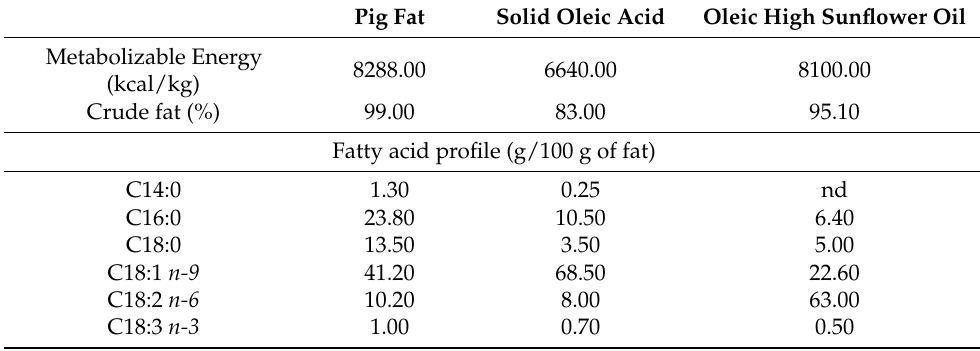
Table 1. Nutritive value and fatty acid composition of different fats. Pig